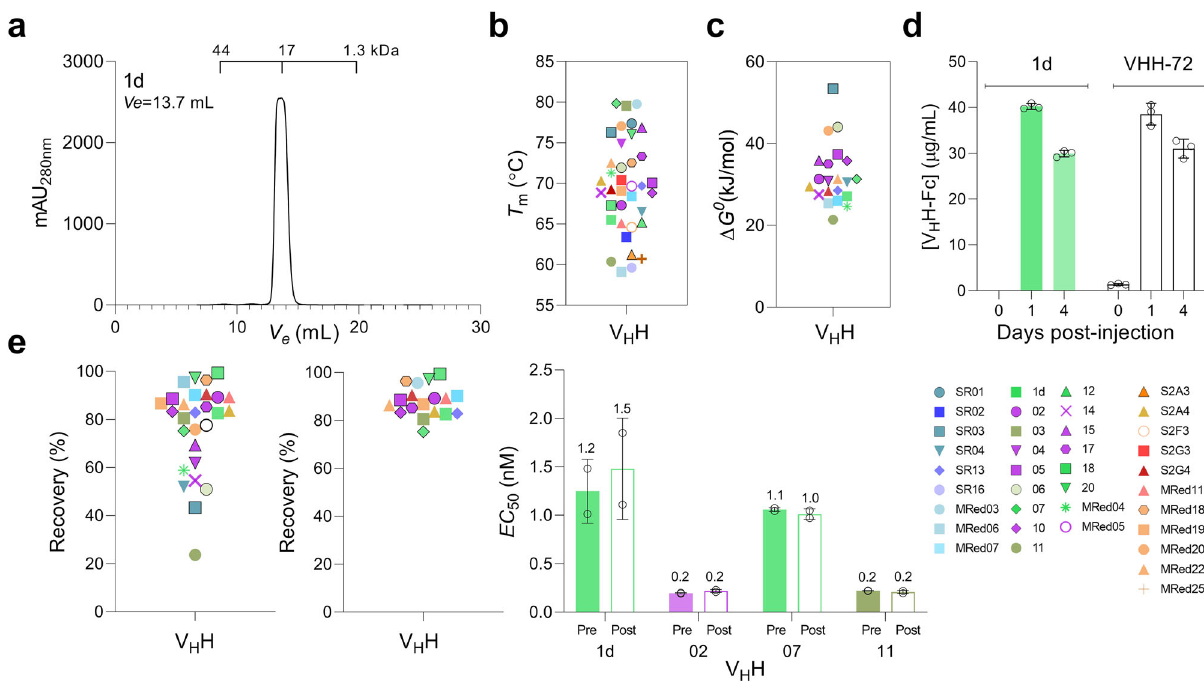
Fig. 3 Stability of anti-SARS-CoV-2 S V H Hs. a Representative SEC pro fi le demonstrating the aggregation resistance of V H Hs. The elution volume ( V e ) positions of molecular mass standards (44 kDa, 17 kDa, 1.3 kDa) are marked. See Supplementary Fig. 8 for the full dataset. b Summary of V H H T m data. T m s were obtained from plots of % folded vs temperature (Supplementary Fig. 9; Supplementary Table 5). c Summary of V H H Δ G 0 data. Δ G 0 (as well as other thermodynamic parameters, C m and m values) are reported in Supplementary Table 5. d In vivo stability and persistence of V H Hs. Stability and persistence were determined by monitoring the concentration of a representative V H H-Fc (1d) in hamster blood at various days post-injection by ELISA. VHH-72-Fc was used as the benchmark. Error bars indicate standard deviation (SD) of three biological replicates (animals). e Stability of V H Hs against aerosolization. Summary of % recovery of all (left panel) and lead (middle panel) V H Hs are shown. Percent recovery represents the proportion of a V H H that remained soluble monomer following aerosolization. Graphs were generated based on the data in Supplementary Fig. 11a and Supplementary Table 6. Open circle in e (Left panel) represents benchmark VHH-72. e (right panel) Activity of pre- vs post-aerosolized V H Hs expressed in terms of antigen binding ( EC 50 ). EC 50 s were determined by ELISA. Error bars indicate standard deviation (SD) of two technical replicates. V H Hs in b , c , e (left panel) and e (middle panel) are color-coded based on their epitope bin designation ( see Fig. 1d). Source data used to generate Fig. 3a, d and e (right panel) are included in Supplementary Data